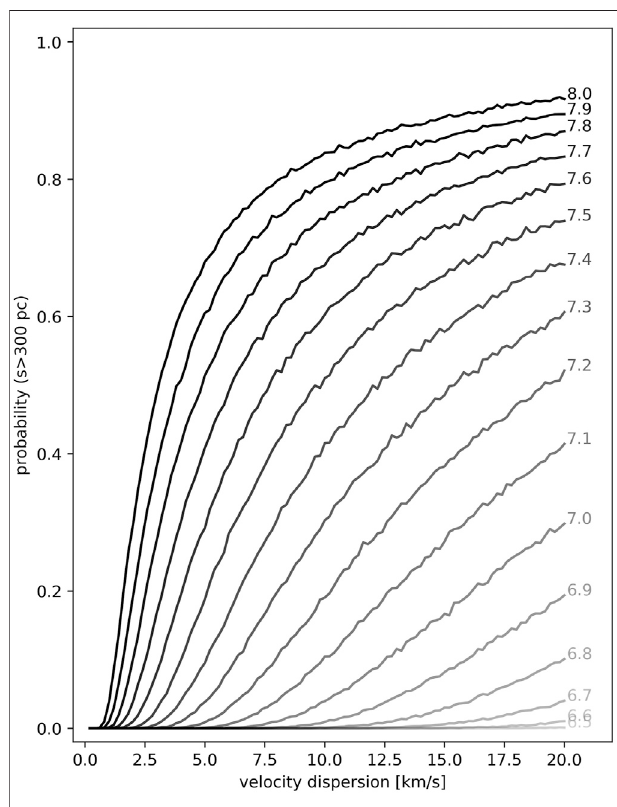
FIGURE 5 | The estimated probability, that a randomly located cluster in a galaxy drifts from the spiral arm (its birthplace), as a function of the velocity dispersion. The simulation was done for multiple cluster ages. The cut-off value for Δ s was chosen tobe 300 pc. The pattern velocity is Ω p (cid:1) 25 km/s/kpc.